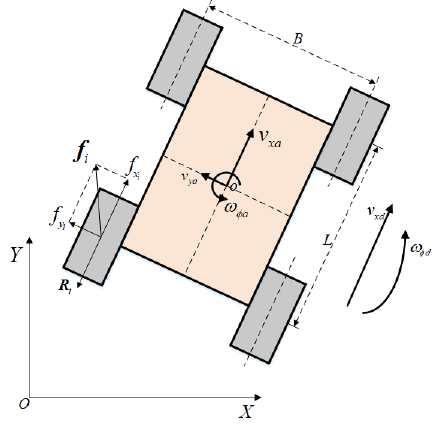
Figure 3. Skid steering vehicle